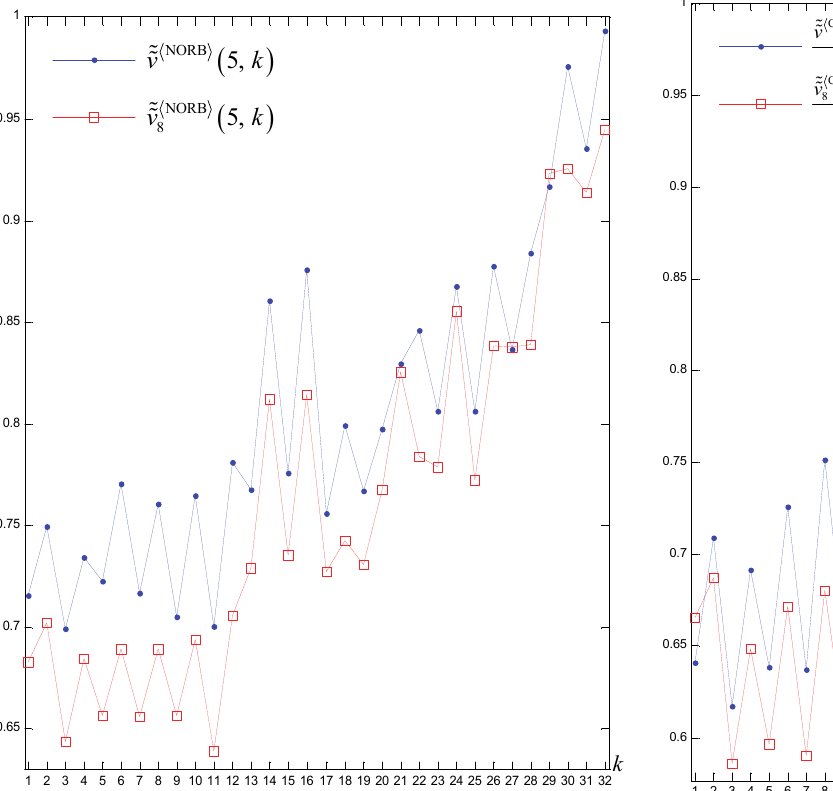
0100 . The peak at 8 k  is obvious.   2